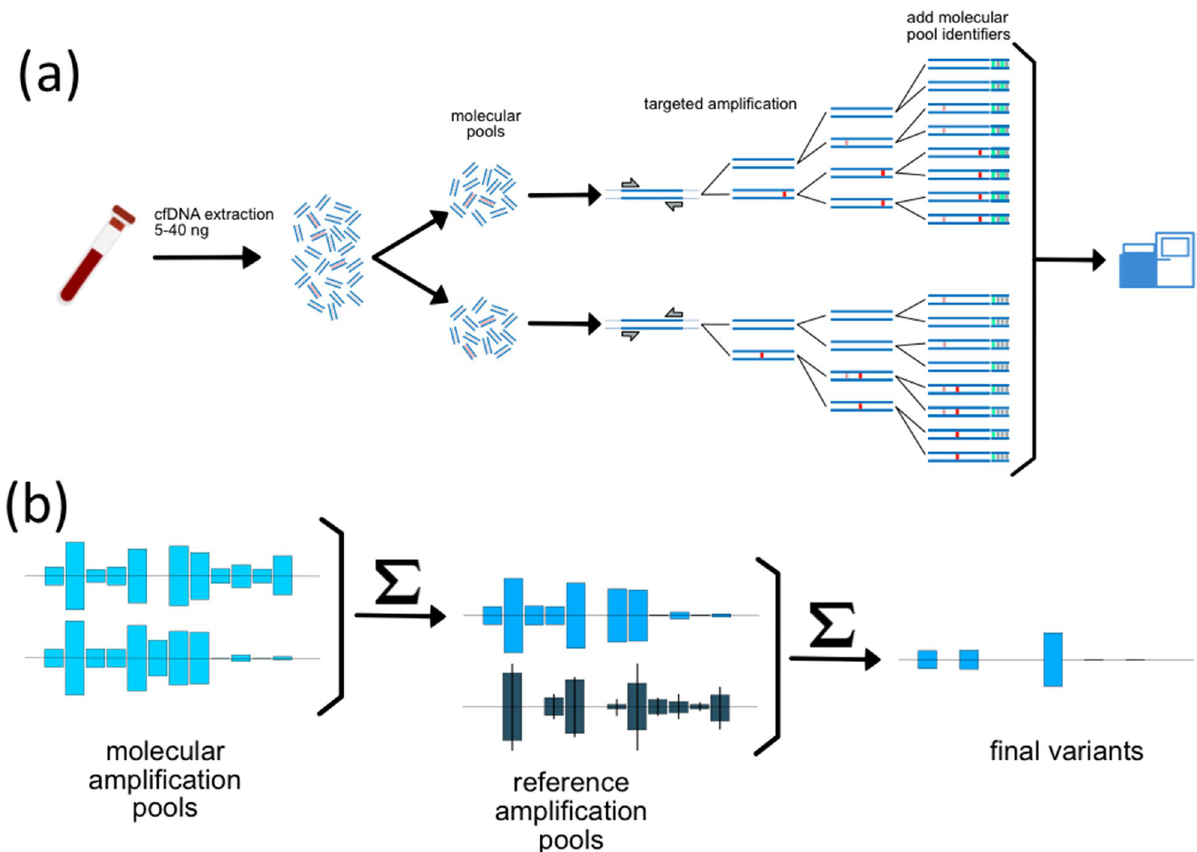
Figure 2. ( a ) Extracted cfDNA is divided into two molecular pools, each containing a fraction of the tumor- derived cfDNA (red fragments). Each molecular pool undergoes a targeted amplification reaction, resulting in the introduction of both stochastic (red) and recurrent (pink) artifacts. Post amplification, each molecular amplification pool (MAP) is indexed and sequenced. ( b ) Variant data from the two molecular pools is statistically compared to eliminate stochastic errors and referenced to a large number of reference molecular pools to eliminate recurrent errors.